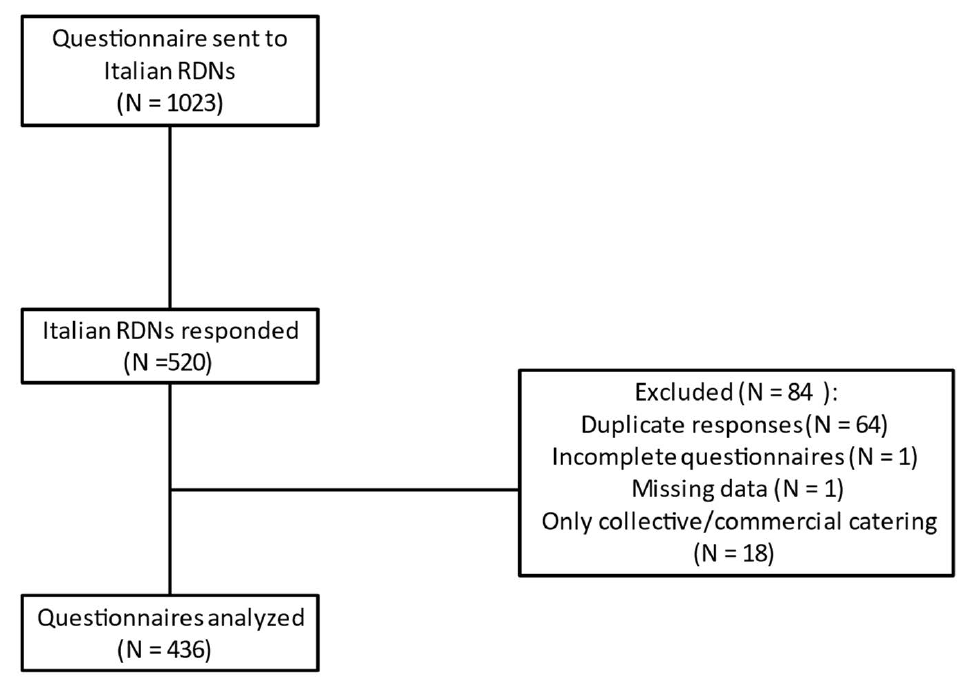
Figure 1. Flowchart of the study. Table 1. Description of the participants’ demographic and professional characteristics ( n =